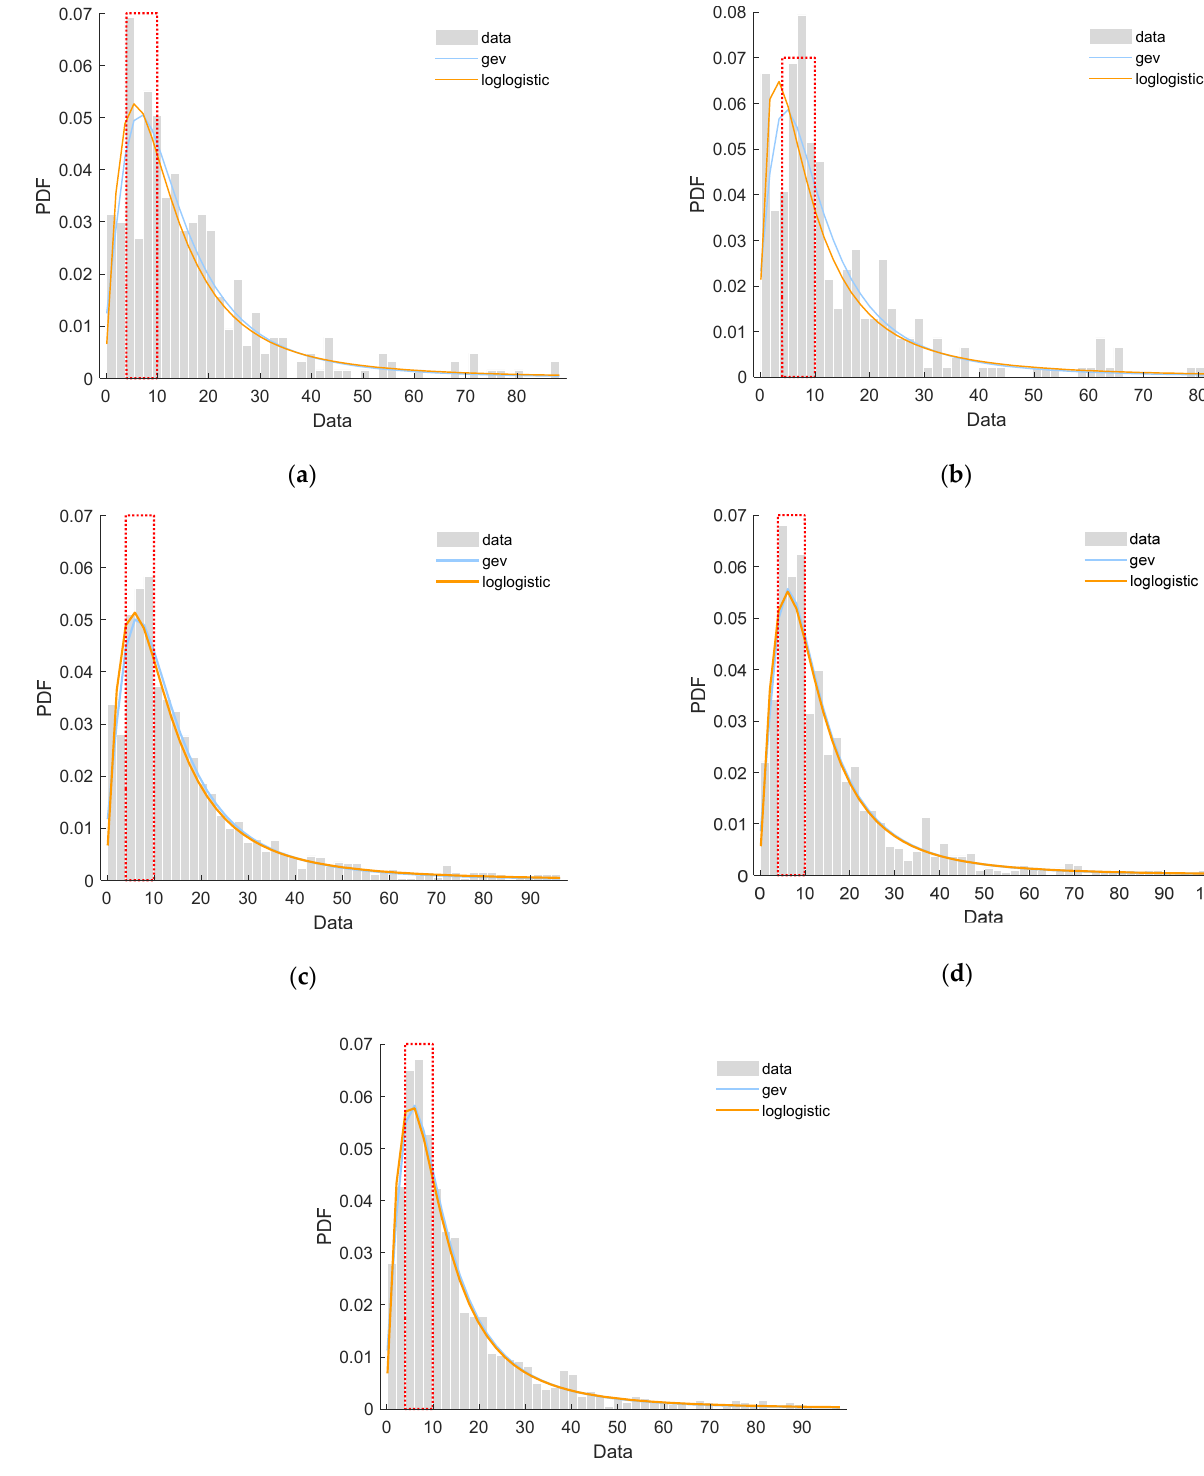
Figure 6. ( a ) Fitting results for universities, ( b ) middle schools, ( c ) malls, ( d ) hospitals, ( e ) metro stations. Table 4. Probability distribution parameters and goodness-of-fit test results.